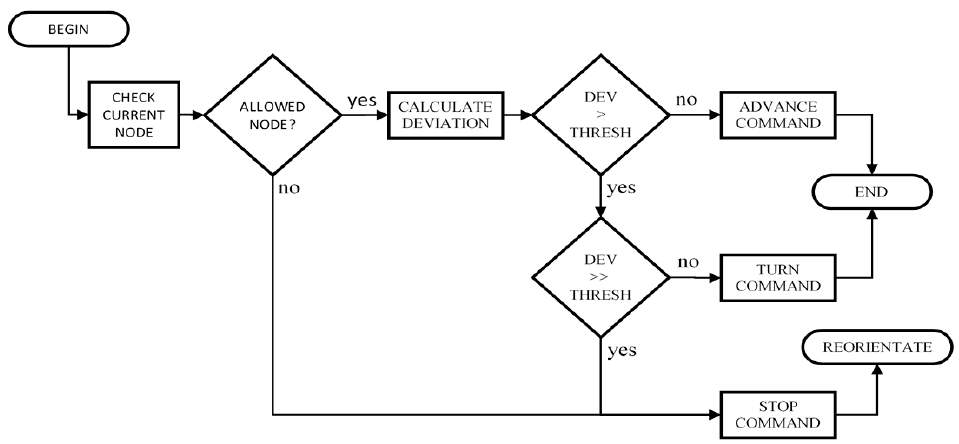
Figure 5. Guidance process to the next point of reference.